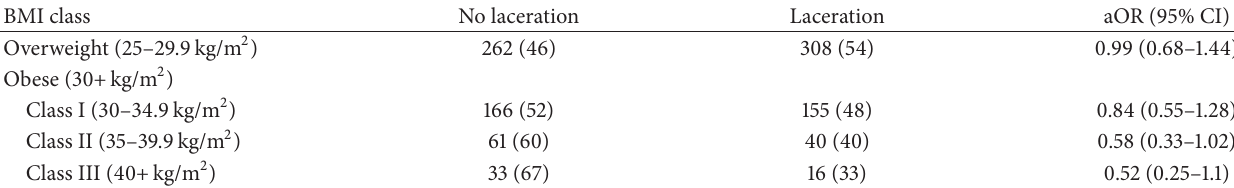
Table 3: Multivariate analysis ∗ of BMI distribution for prediction of risk of